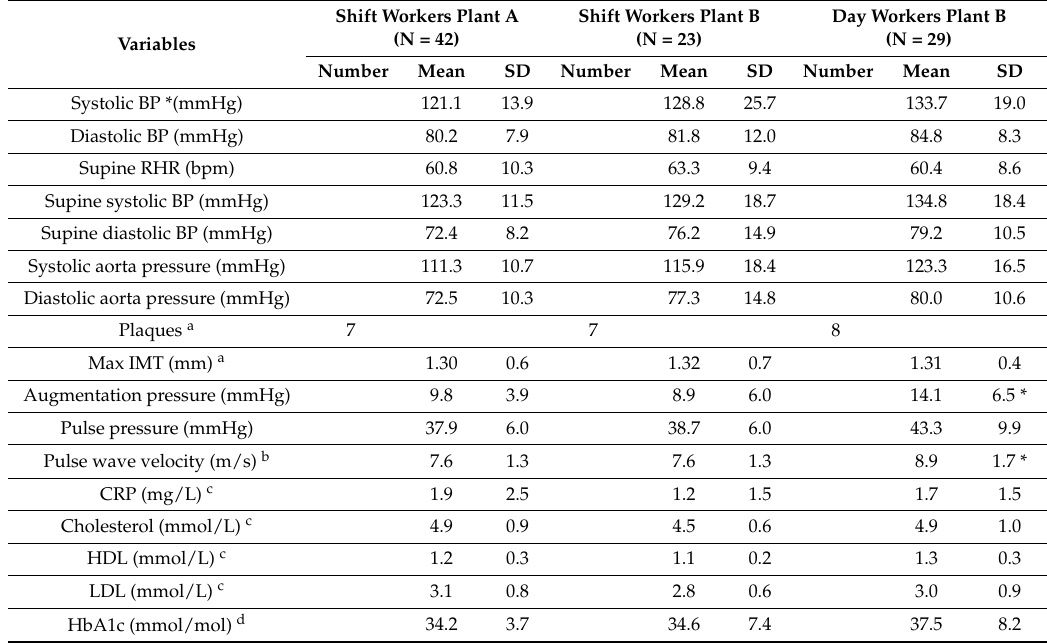
Table 3. Cardiovascular outcomes among shift and day workers (N = 94).